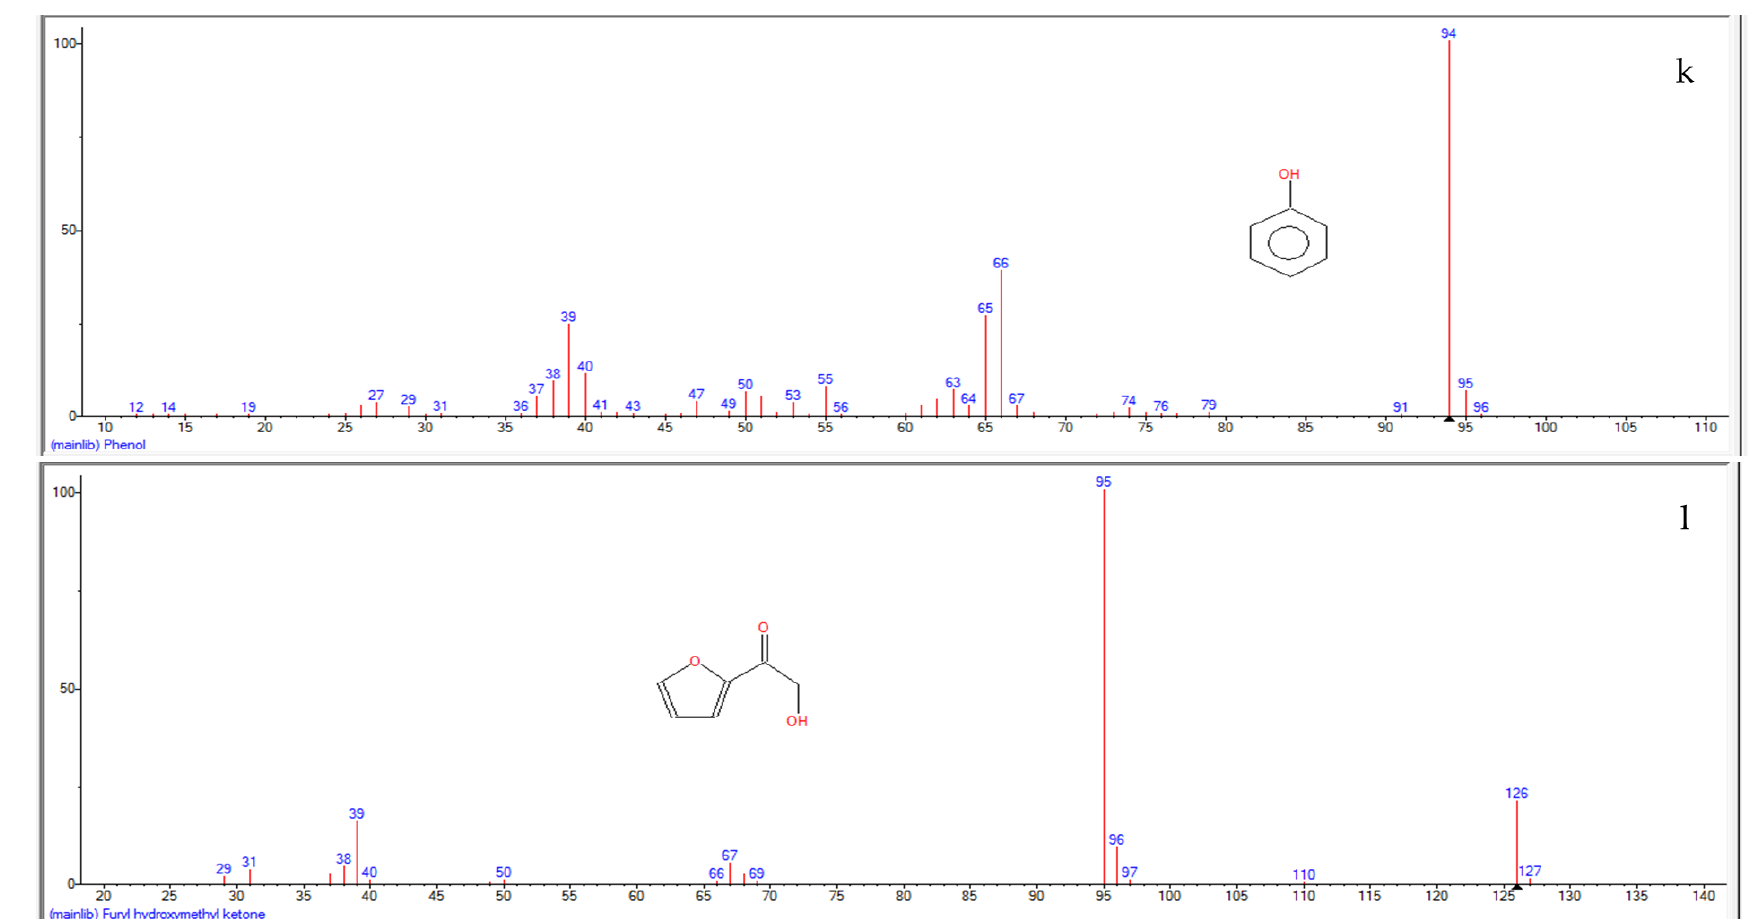
Figure 3. Mass spectrum of 12 semi-volatile compounds identified in Gelam honey: a : 3-Penten-2-one, 4-methyl-; b : 2-Pentanone, 4-hydroxy-4-methyl-; c : 1,3-Dihydroxyacetone dimer; d : Benzene, (1-methylethyl)-; e : 1H-Pyrazole, 4,5-dihydro-4, 5-dimethyl-; f : 4H-Pyran-4-one, 2,3-dihydro, 3,5-dihydroxy-6-methyl-; g : 2-Furanmethanol; h : α-Methylstyrene; i : 5-Hydroxymethylfurfural; j : 2-Cyclopenten-1-one, 2-hydroxy-; k : Phenol; l : Furyl hydroxymethyl ketone.